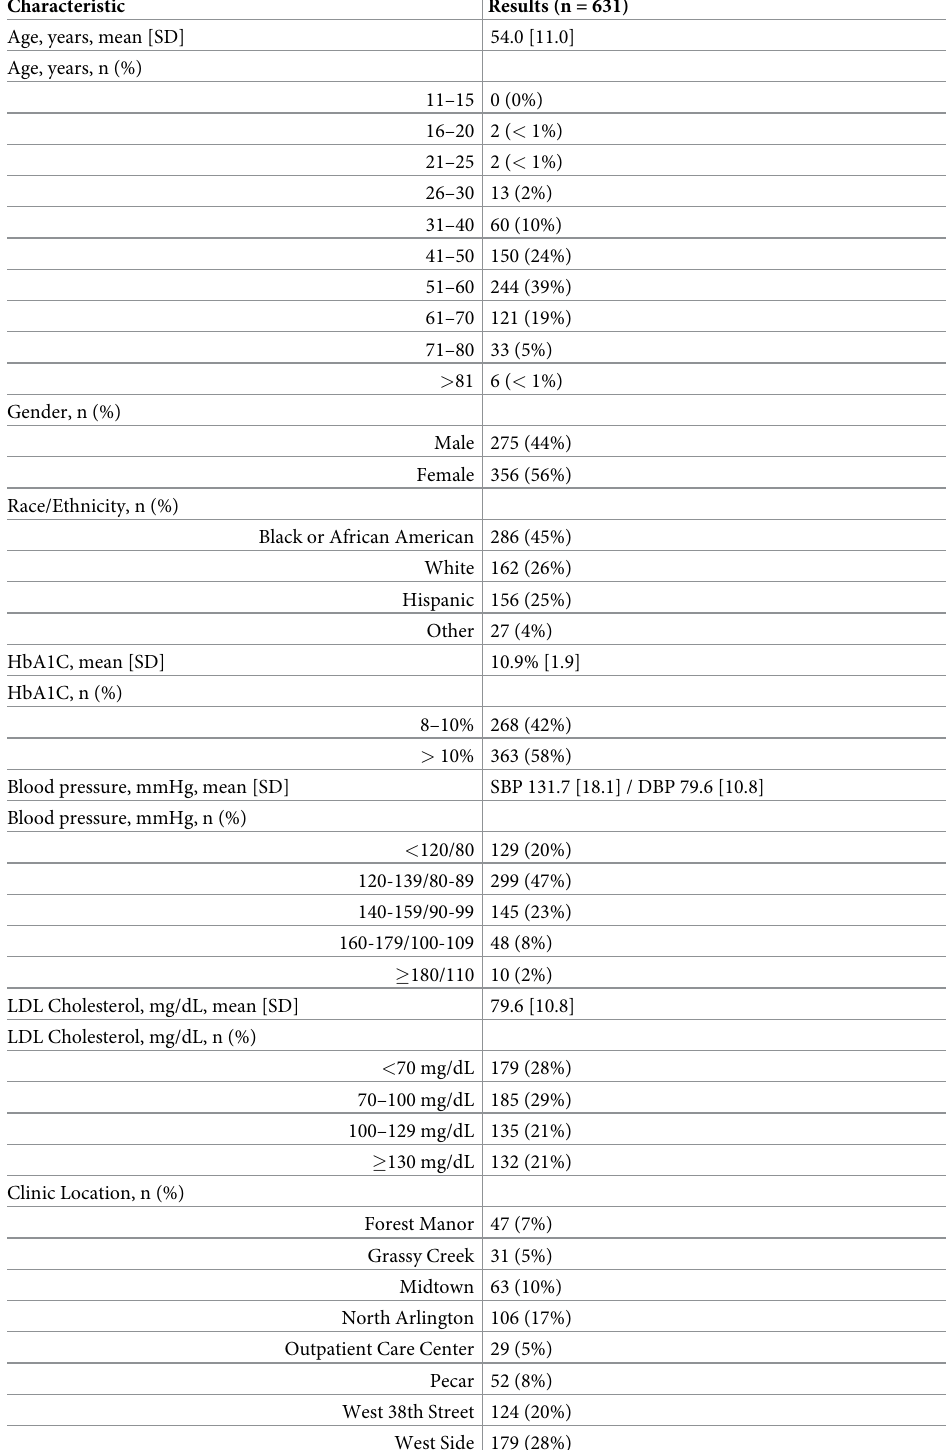
Table 1. Baseline demographic